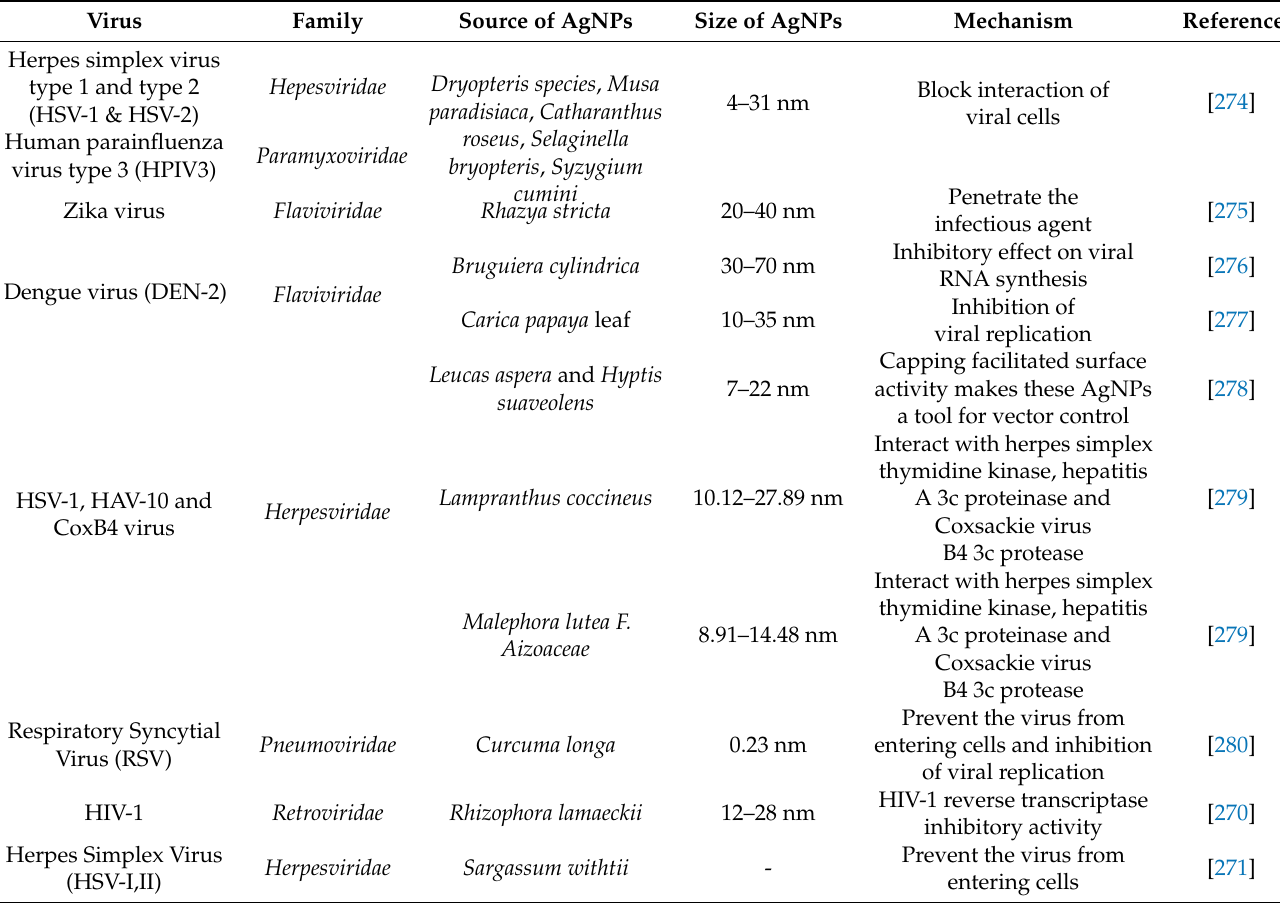
Figure 12. The antiviral activities of AgNPs [273]. Table 4. The antiviral properties of biogenic